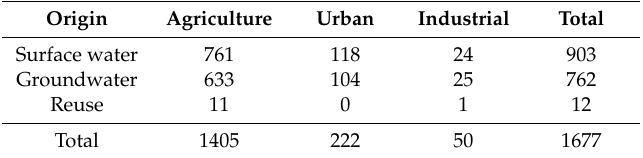
Table 2. The main water users in the JRB. Source. CHJ [35].